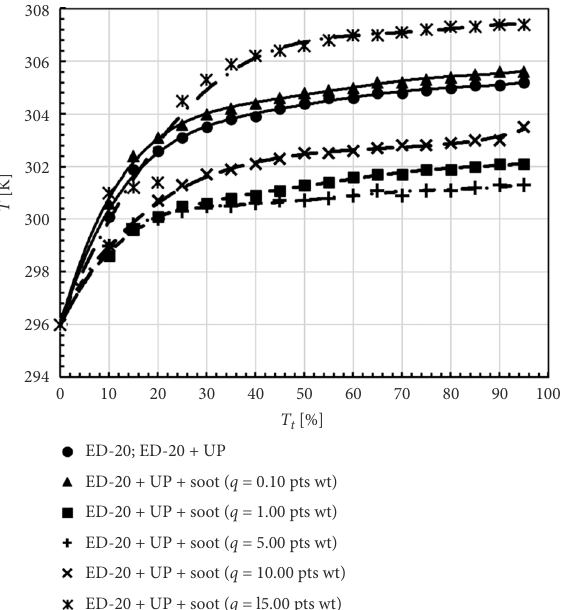
Figure 6. Torque variation relative to the temperature of exoeffect during the curing of epoxy composites with different concentrations of nanodispersed